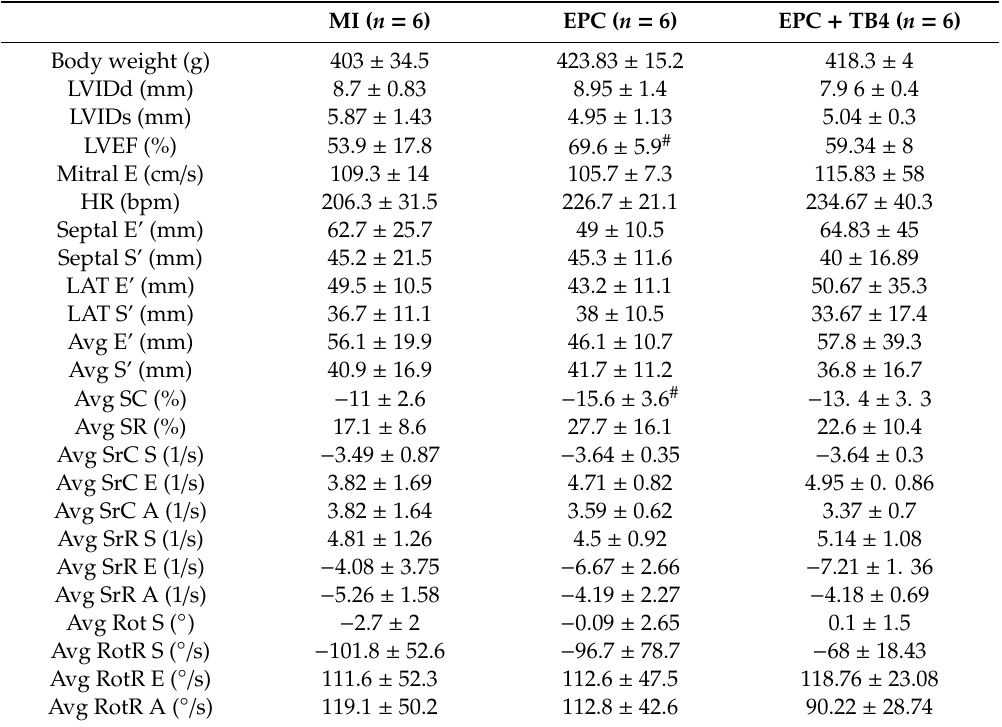
Table 1. E ff ects of transplanted EPC with and without TB4 on echocardiographic